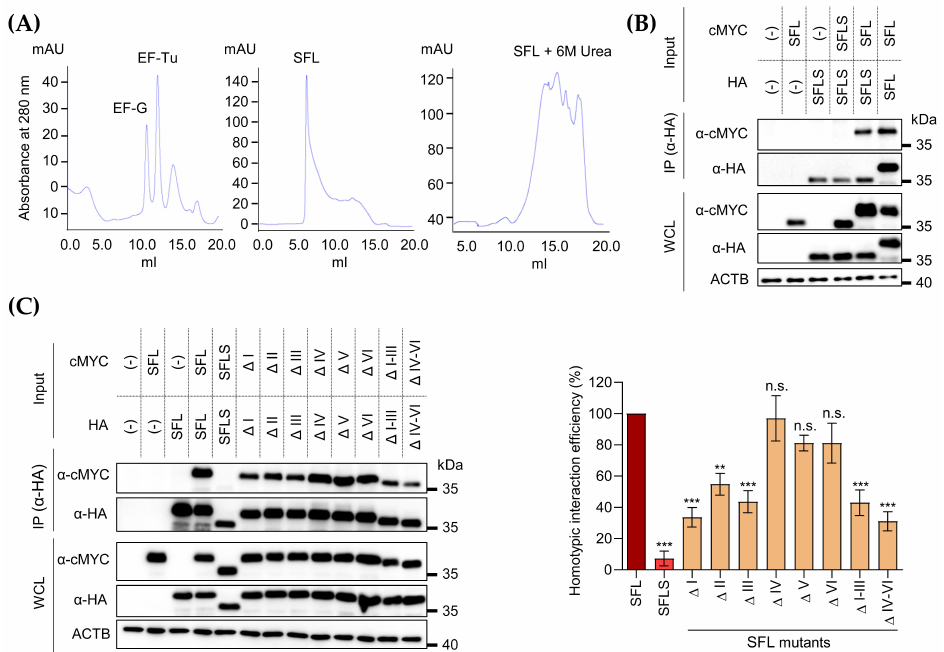
Figure 5. Effect of RAA deletions for SFL self-interactions. ( A ) Analytical gel filtration profiles for (i) EF-G and EF-Tu, (ii) SFL and (iii) SFL treated with 6 M urea. The indicated proteins were loaded